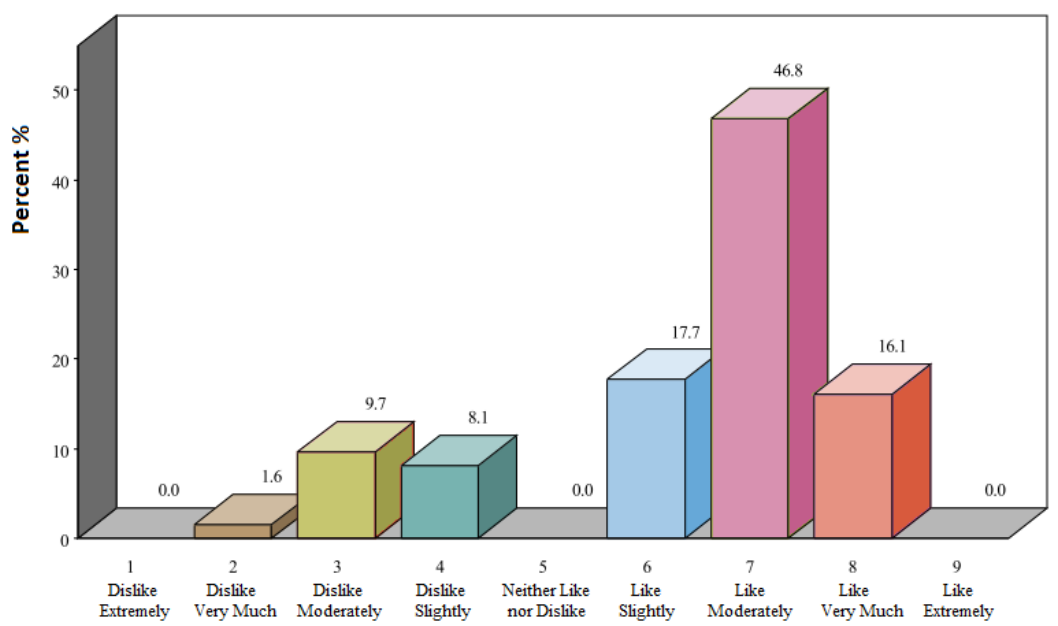
Figure 1. Overall acceptability of taste.